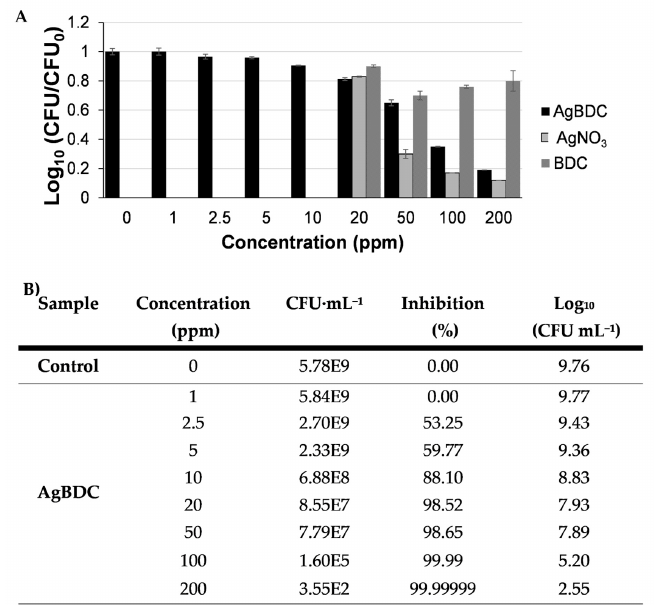
Figure 4. ( A ) E. coli CFU·mL − 1 (represented as the logarithmic ratio, with C0 being the CFU·mL − 1 of the positive control for better comparison) in contact with AgBDC suspension after 18 h of incuba- tion. ( B ) Determination of planktonic E. coli bacterial viability by plate count after 18 h in contact with the AgBDC suspension: the correlation between CFU·mL − 1 , Log 10 and inhibition %.